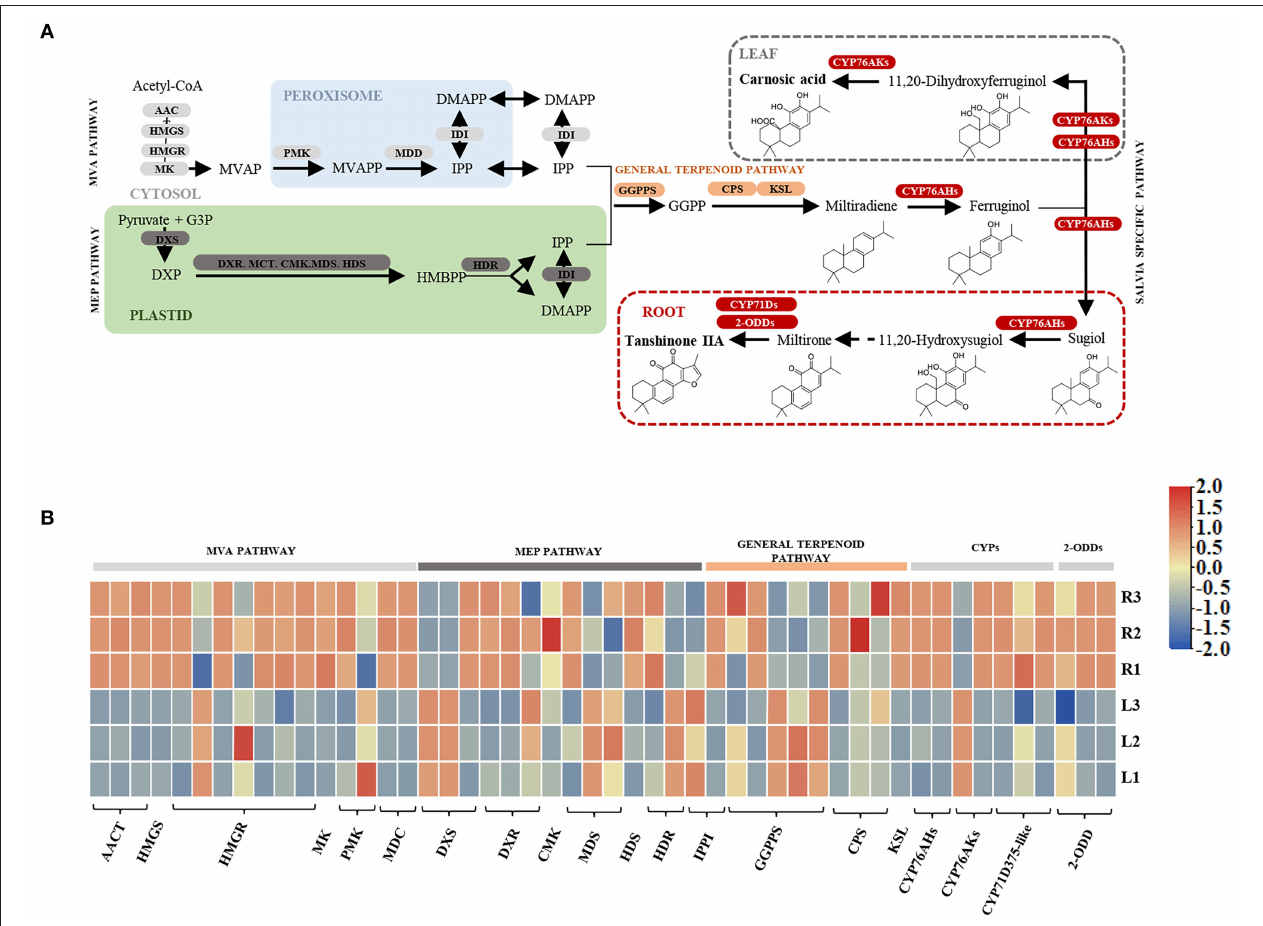
FIGURE 5 | A proposed biosynthetic pathway of abietane-type diterpenoids (ATDs) in S. apiana . (A) Pathways and genes involved in the ATDs biosynthesis. (B) Transcription profile of candidate ATDs biosynthetic genes in roots and leaves of S. apiana . Three biological replicates from the leaf (L) and root (R) were plotted individually. AACT, Acetyl-CoA acetyltransferase activity; CYP, cytochrome P450; 2-ODD, 2-oxoglutarate-dependent dioxygenase; HMGS, 3-hydroxy-3-methylglutaryl coenzyme A synthase; HMGR, hydroxymethylglutaryl-CoA reductase; KSL, kaurene synthase-like enzymes; MK, mevalonate phosphotransferase; MVAP, mevalonate 5-phosphate; PMK, phosphomevalonate kinase; MVAPP, mevalonate 5-diphosphate; MDD, mevalonate diphosphate decarboxylase; IPP, isopentenyl diphosphate; IDI, isopentenyl diphosphate delta-isomerase; DMAPP, dimethylallyl diphosphate; DXS, 1-deoxy-D-xylulose-5-phosphate synthase;